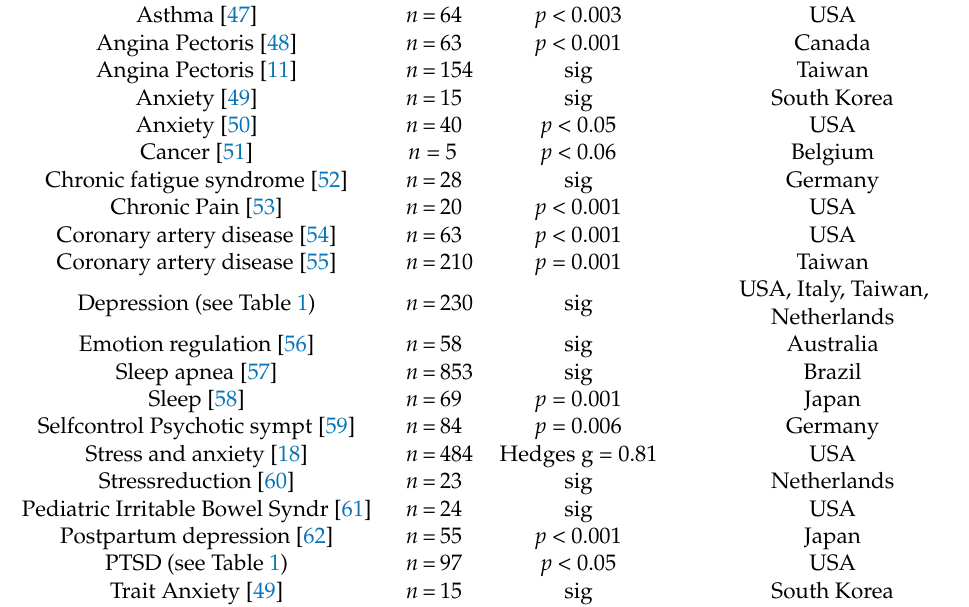
Table 2. Search HRVB RCT